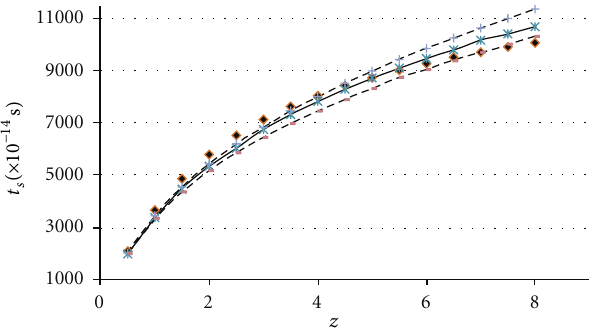
Figure 5: Potential best-fit function (solid line), upper and lower limits due to measurement error (dashed lines), and Λ CDM model